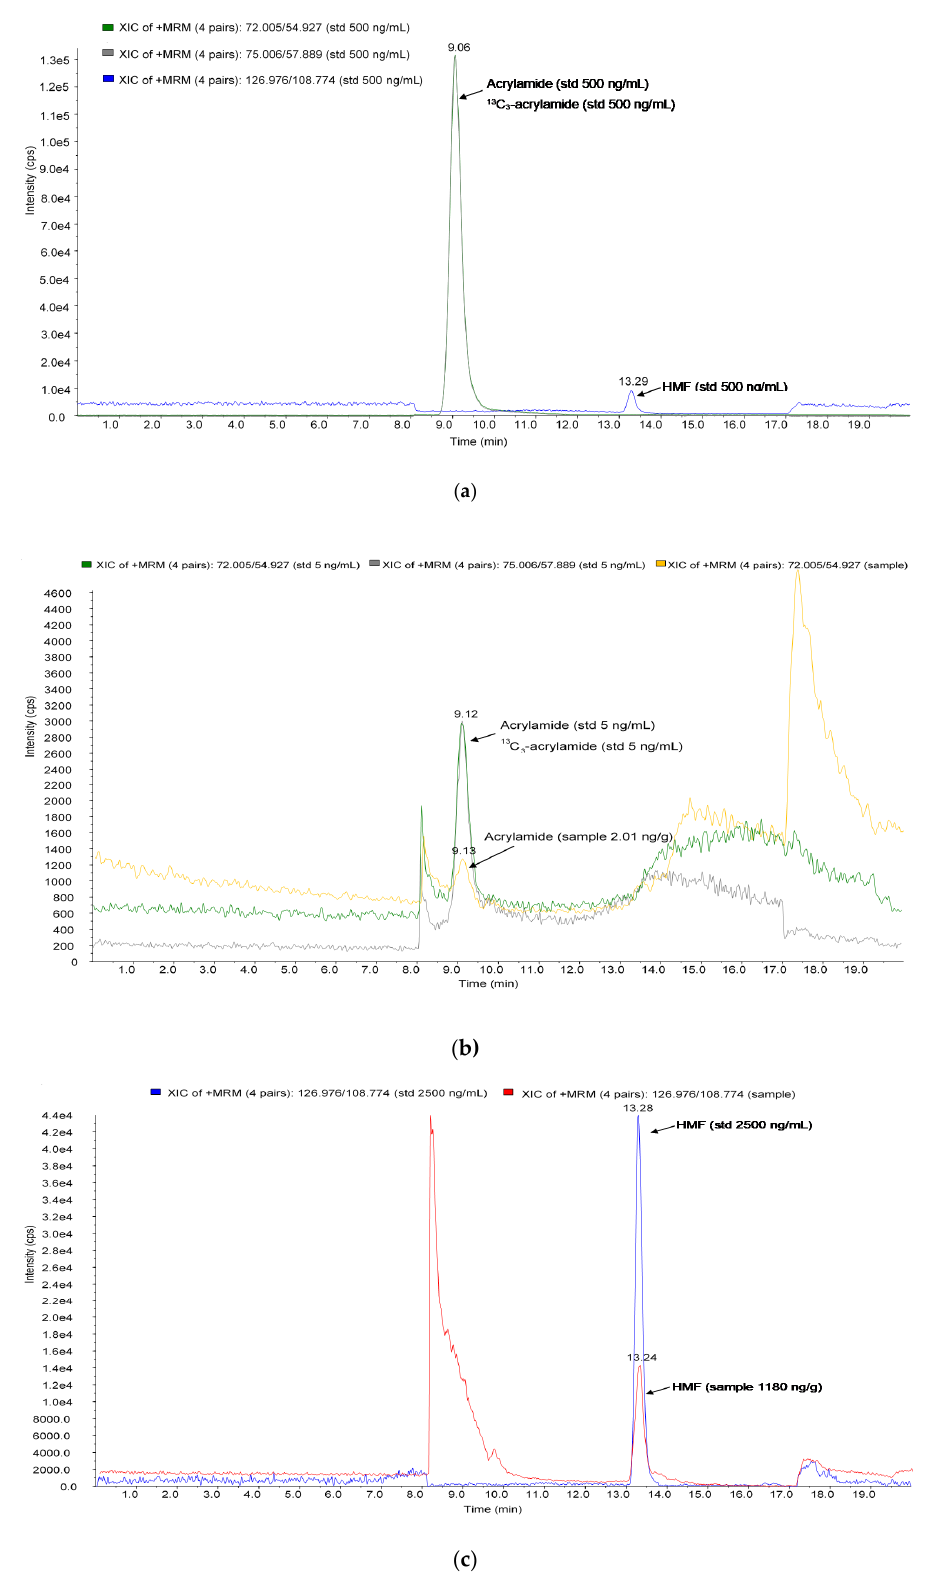
Figure 2. Chromatograms of the: ( a ) standard solution of acrylamide, 13 C 3 -acrylamide and HMF (500 ng / mL); ( b ) standard solution of acrylamide and 13 C 3 -acrylamide (5 ng / mL) and extruded sample with detected 2.01 ng / g of acrylamide; ( c ) standard solution of HMF (2500 ng / mL) and extruded sample with detected 1180 ng / g of